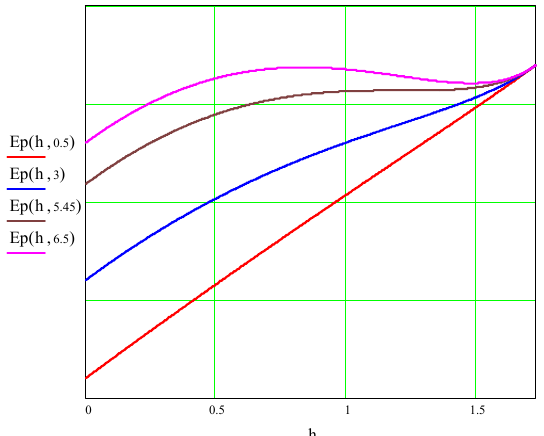
Figure 5. Graph of the potential energy of the average cylinder for different k.